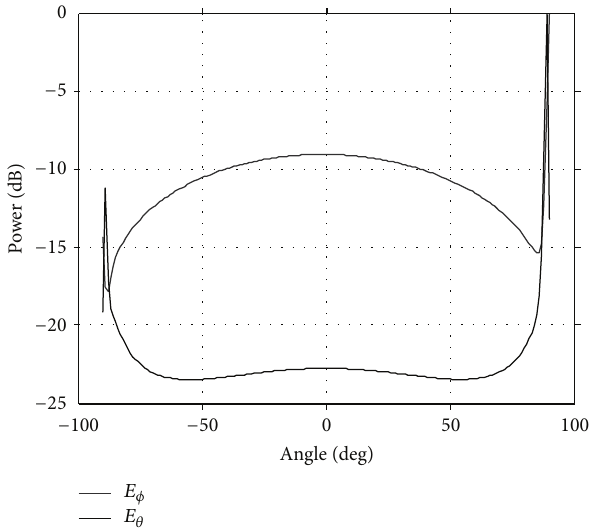
Figure 12: Radiation pattern of circular waveguide at 𝑟 = 0.3𝜆 (0.96 cm).